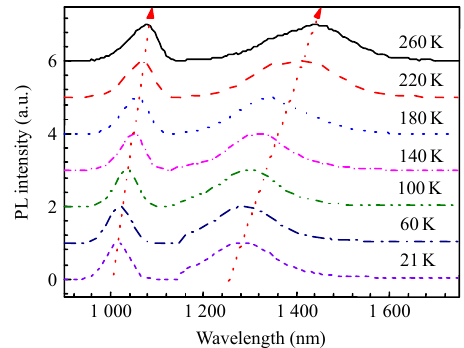
Fig. 2 PL spectra measured from 21 K to 260 K with a laser excitation intensity of 9 W/cm 2 .